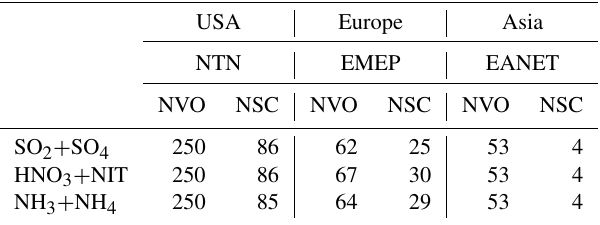
Table 5. Number of sites with wet deposition observation (NVO) and number of sites satisfying criterion (NSC) at surface monitoring networks in the US, Europe, and